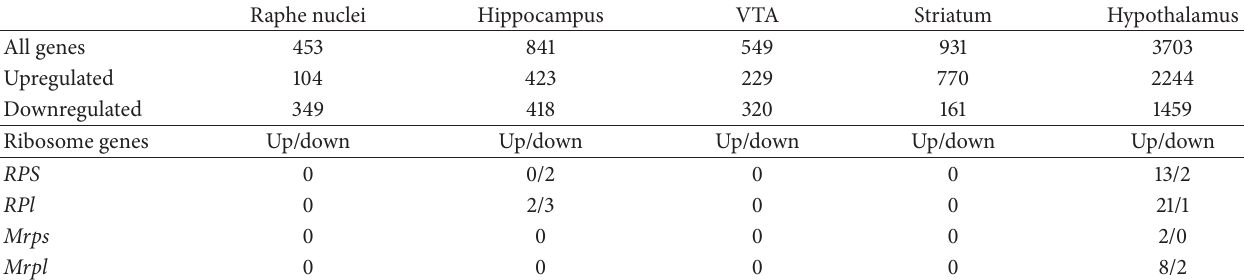
Table 1: The number of genes that changed their expression in brain regions of depressive male mice.